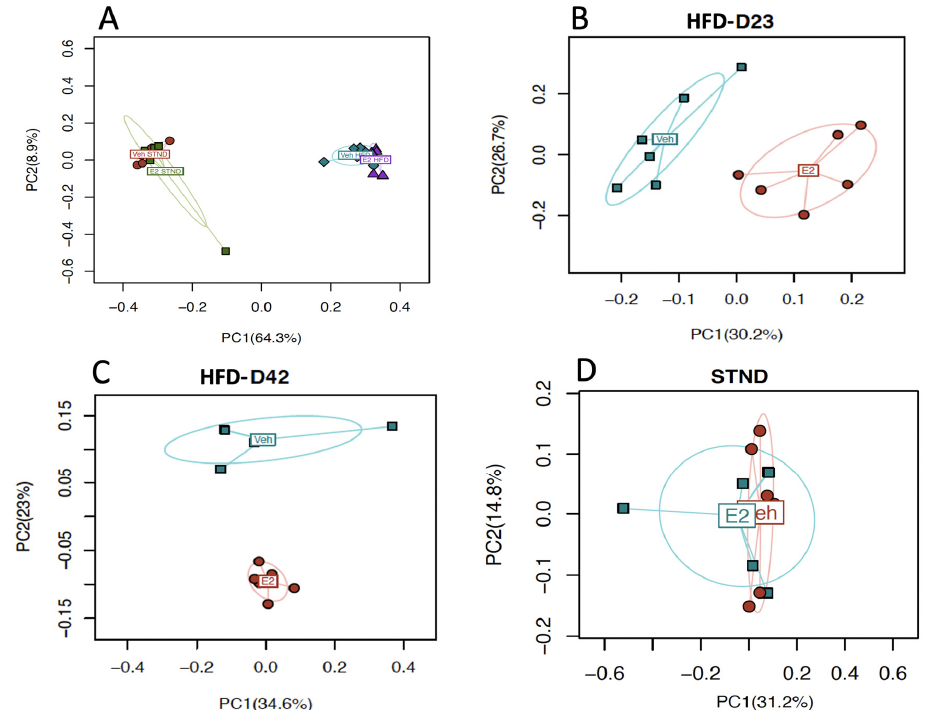
Figure 7. Estradiol and HFD alter gut microbiota β -diversity in female mice. Bray-Curtis distance between aggregate microbiota communities shows a distinct clustering between STND and HFD ( A ) and between E2 and Veh-treated animals during HFD, on Day 23 ( B ) and Day 42 ( C ), but not during STND ( D ). For A, (n = 12/group) and for B-D, (n = 6/group). p < 0.05 (PERMANOVA) considered significant.